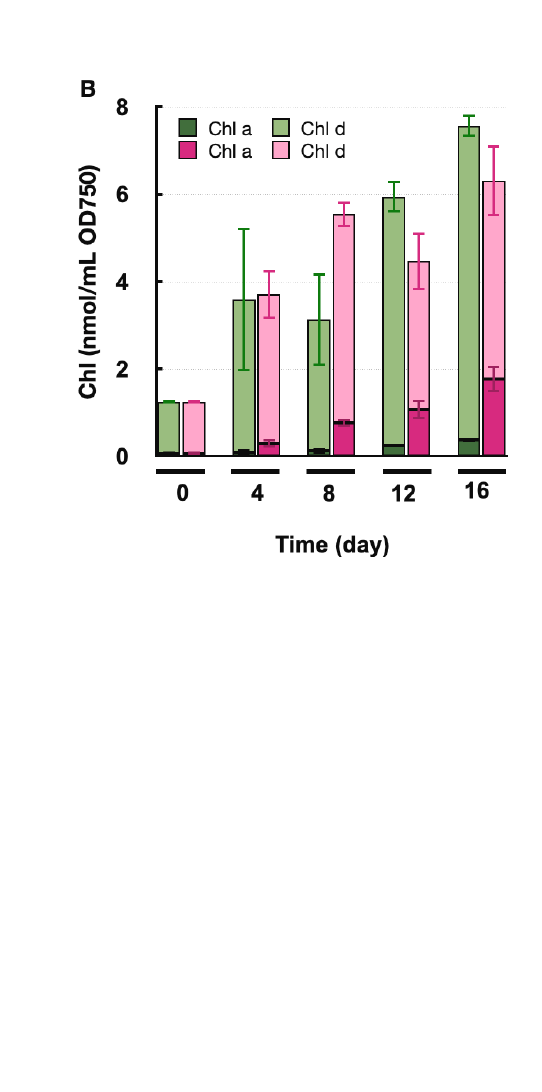
Figure 3. Dark heterotrophic growth and Chl a / d content in A. marina. ( A ) A. marina was grown in liquid IMK medium under photo-autotrophic conditions (green circle) and dark-heterotrophic conditions (pink square). ( B ) The amounts of Chl a (dark green/dark pink) and Chl d (green/pink) were measured on days 0, 4, 8, 12, and 16 of cultivation in photo-autotrophic (green) and dark- heterotrophic (pink) conditions, respectively. ( C ) The ratio of cellular Chl a / d amount in photo- autotrophic conditions (green circle) and dark-heterotrophic conditions (pink square).